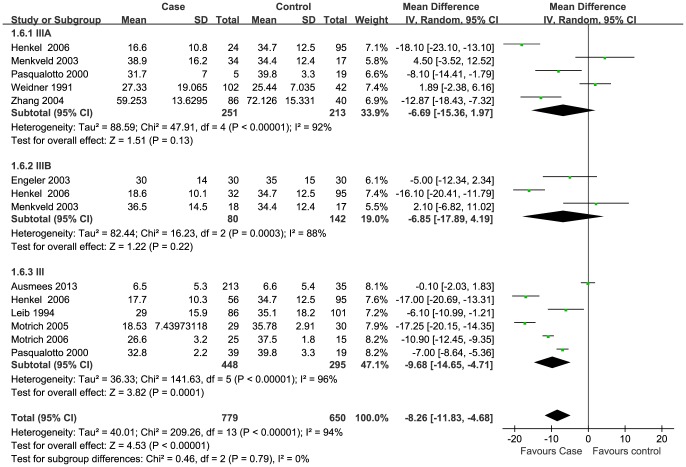
Forest plot showing the meta-analysis outcomes of the effect of CP/CPPS on sperm normal morphology.